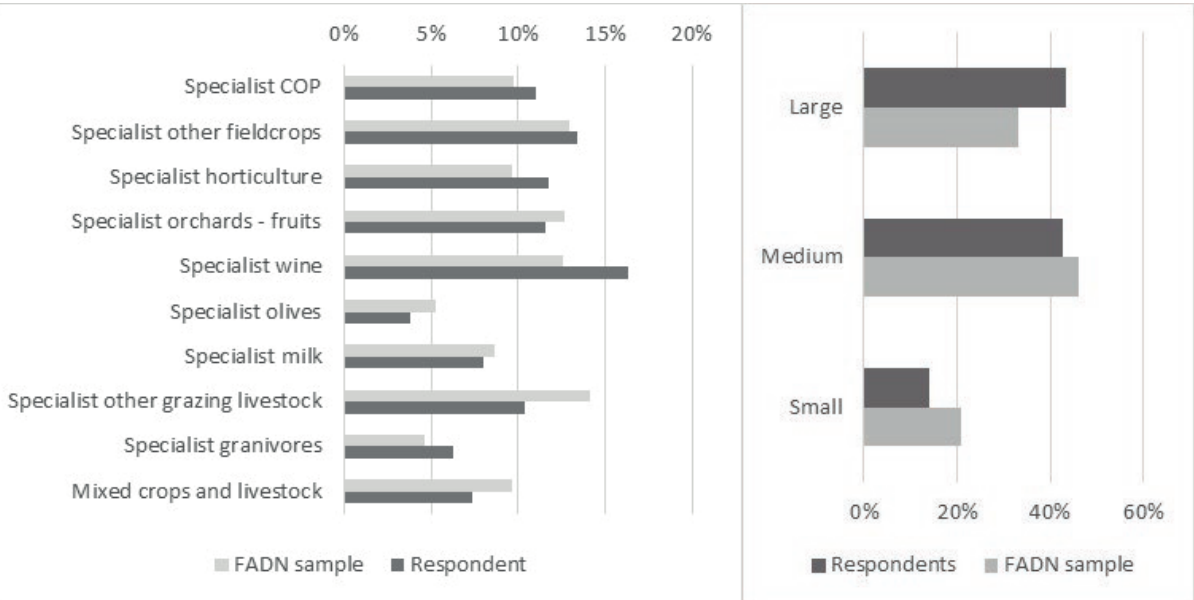
Figure 2. Comparison of FADN sample and subsample of respondents per FT and FS. Source: own elaboration on FADN and collected